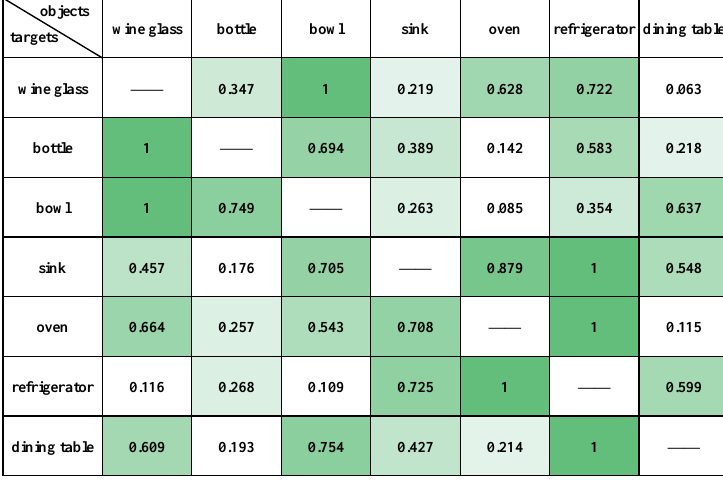
Figure 8. The semantic association model for the kitchen places.